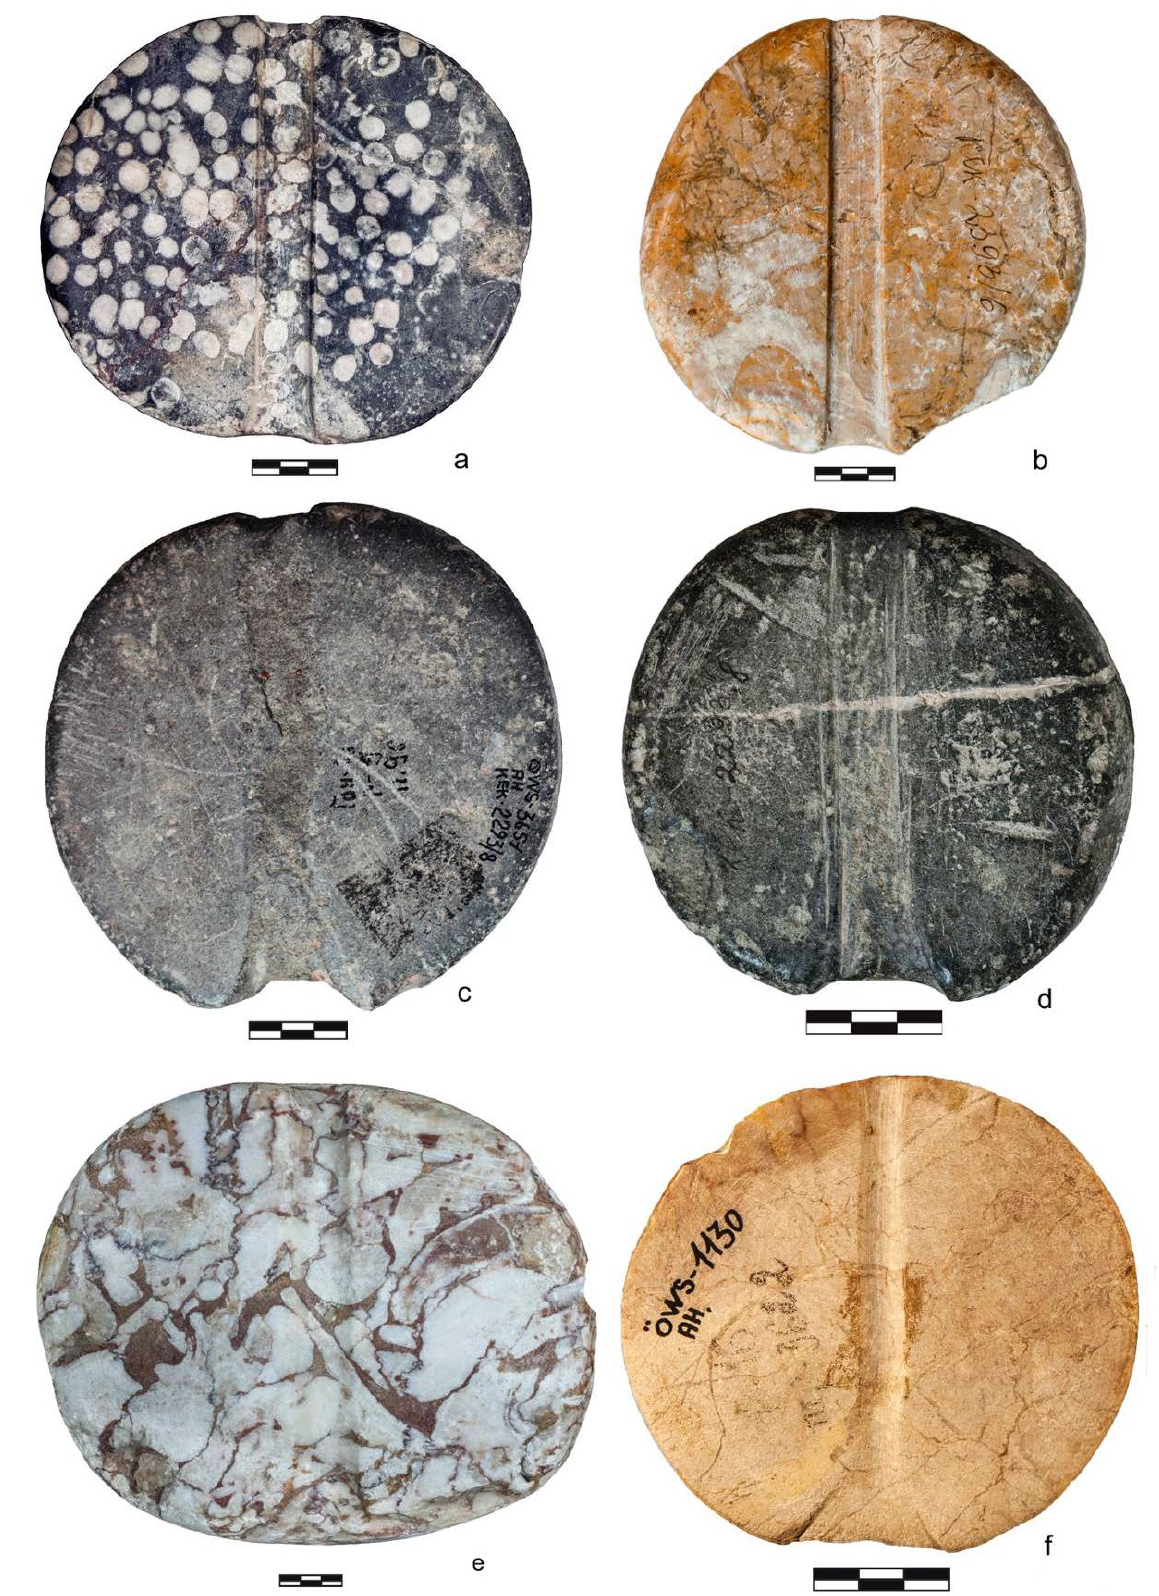
Figure 8. The main types of grooves on the top and bottom bases of miniature columns from Gonur Depe: a, b. with a rectangular profile and identical ends; c, d. with a rectangular profile and a deep trapezoidal extension at one end; e, f. with an arched profile and a deep trapezoidal extension at one end. Scale bar is 3 cm long, separated into three 1 cm